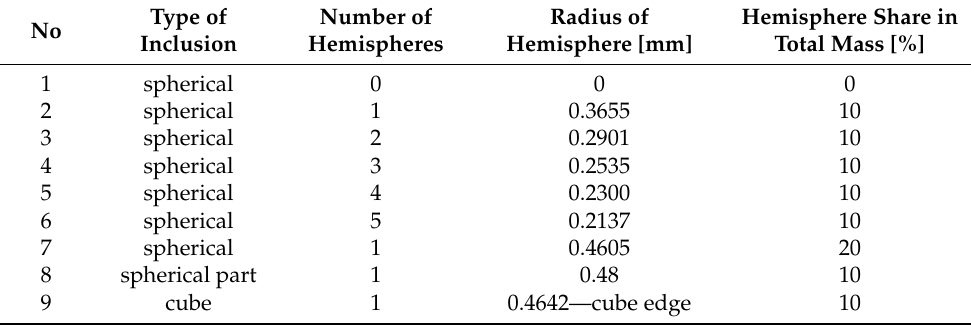
Figure 3. Exemplary geometrical models in the calculation program Comsol: ( a ) 1 hemisphere, ( b ) 3 hemispheres, ( c ) 5 hemispheres, ( d ) cube, ( e ) part of hemisphere. Table 1. Geometric dimensions of numerical models in relation to unit value.